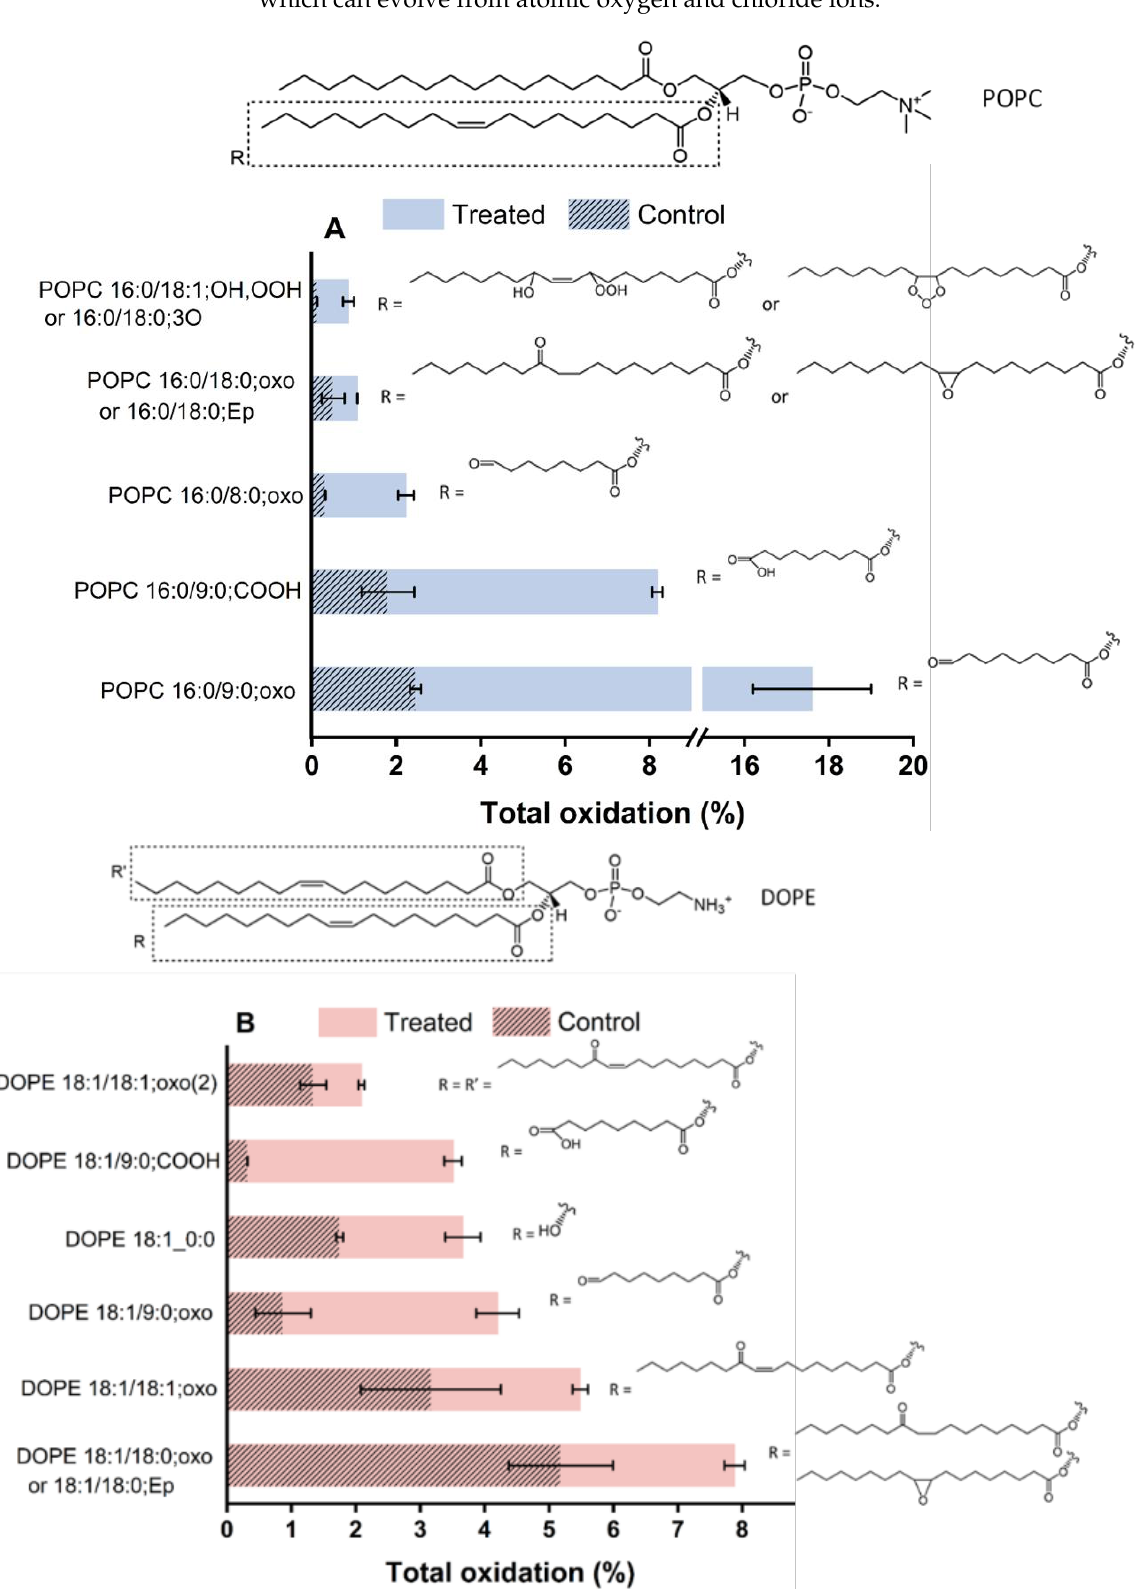
Figure 6. ( A ) Concentration of reactive species produced after 5 min plasma treatment of PBS (pH 7.4), ( B ) 1 O 2 was detected using the SOSG assay, ( C ) Differential pulse voltammograms of 10 mM K 4 [Fe(CN) 6 ] in PBS recorded for the POPC lipid bilayer after 5 min plasma treatment, and after 5 min incubation of the bilayer with selected long-lived RONS, the added concentrations matched current conditions, indicative of the absence or a low concentration of hypochlorite OCl − , with results from 5 min plasma treatment. which can evolve from atomic oxygen and chloride ions.